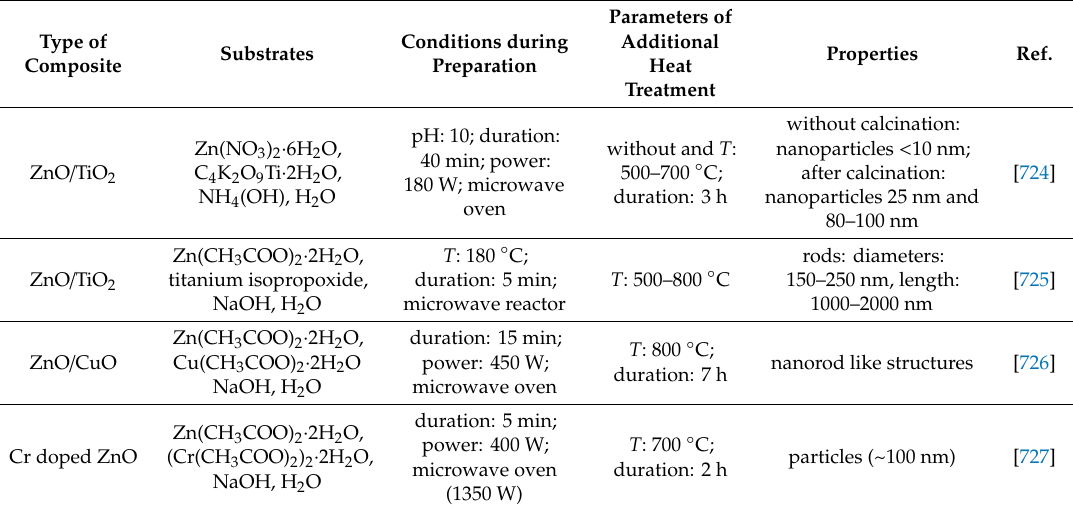
Table 8. Summary of the microwave hydrothermal synthesis of ZnO nanocomposites or ZnO hybrid nanostructures with additional heat